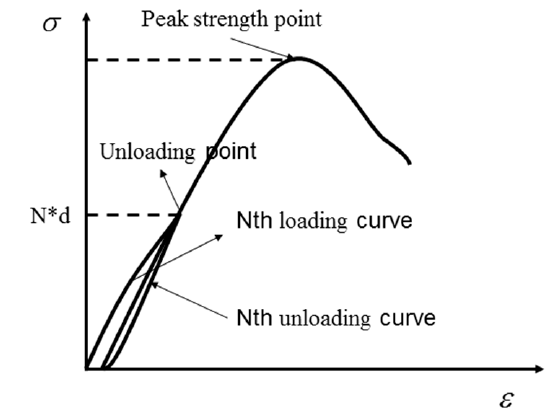
Figure 3. Photos of experimental system. ( a ) Loading system, ( b ) specimen pedestal, and ( c ) specimen pedestal.